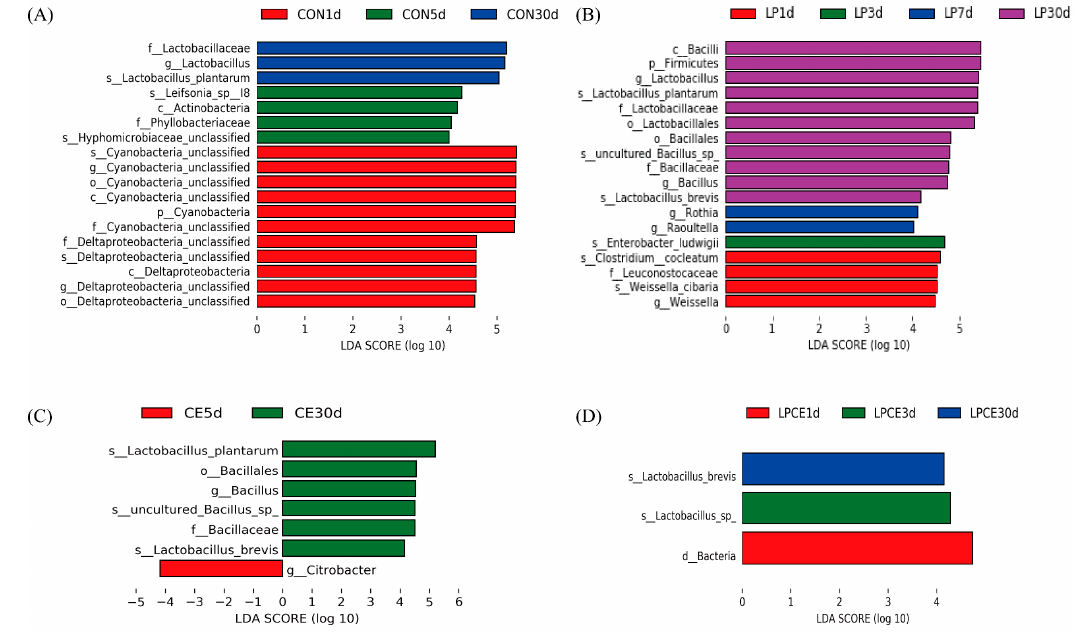
Figure 3. Comparison of the microbial variations using the LEfSe online tool for the mixed silage. ( A ) microbial difference of the CON group in the whole silage process; ( B ) microbial difference of the LP group in the whole silage process; ( C ) microbial difference of the CE group in the whole silage process; ( D ) microbial difference of the LPCE group in the whole silage process. CON, control silage, no additive; LP, silage containing Lactiplantibacillus plantarum ; CE, silage containing cellulase; LPCE, silage containing Lactiplantibacillus plantarum + cellulase.